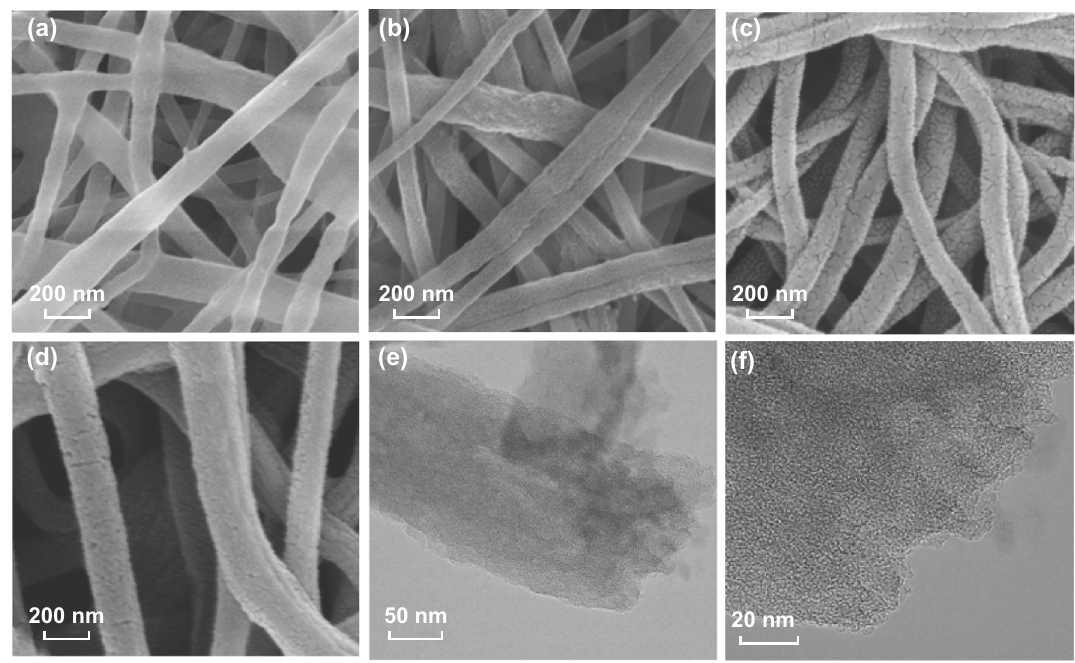
Fig. 1 SEM images of a electrospun PAN/PVP/PVDF nanofibers, b PAN/PVDF porous nanofibers after hydrothermal treatment, N, F-MCFs with different compositions, c PAN/PVP/PVDF = 1/1/1, and d PAN/PVP/PVDF = 1/1/1.5. e , f TEM images of N,